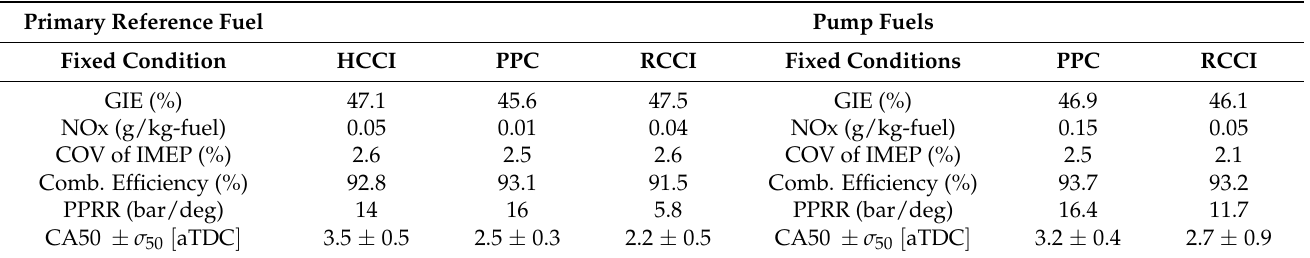
Table 3. Review and comparison between three different advanced combustion technologies